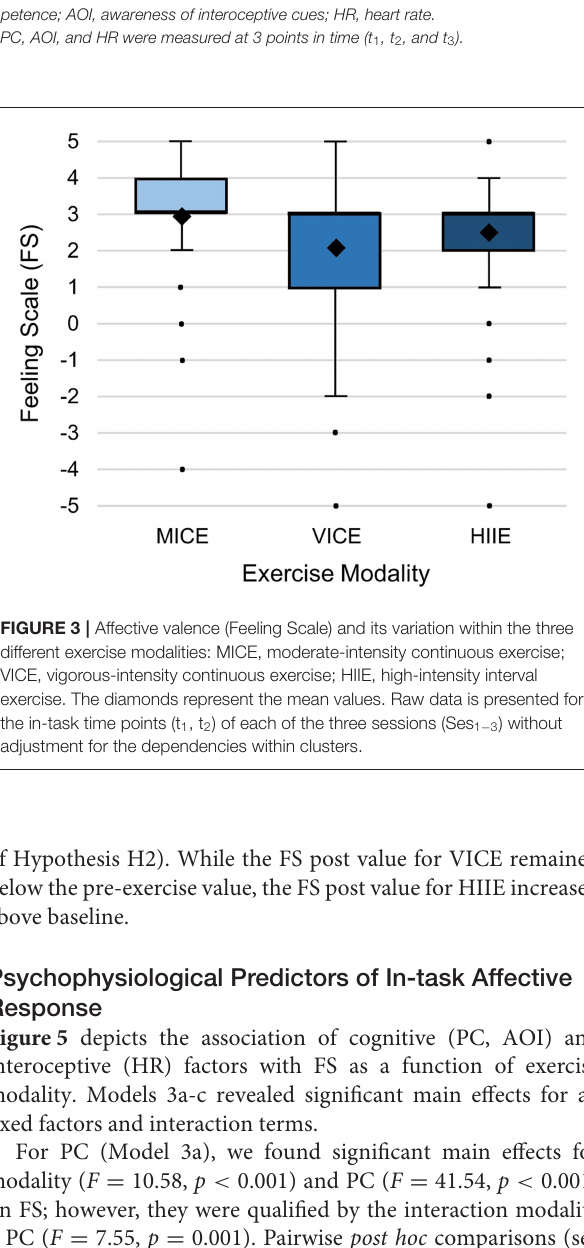
of Hypothesis H2). While the FS post value for VICE